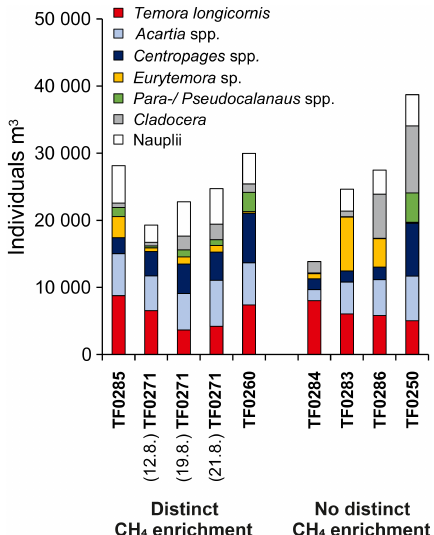
Figure 10. Average zooplankton community composition between the sea surface and the halocline for stations with distinct (left bars) and without distinct (right bars) subthermocline methane enrich- ments. Three replicate samples were taken at station TF0271 in a period of 10 days to investigate the temporal variability in the com- munity composition at this